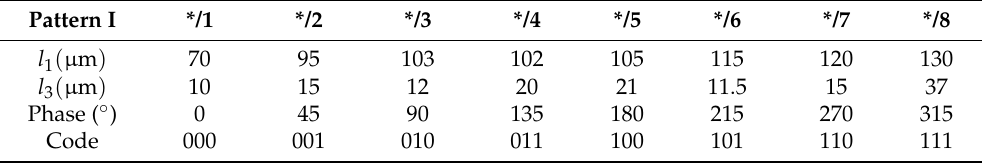
Table 1. Parameters of the eight structures of Pattern I.